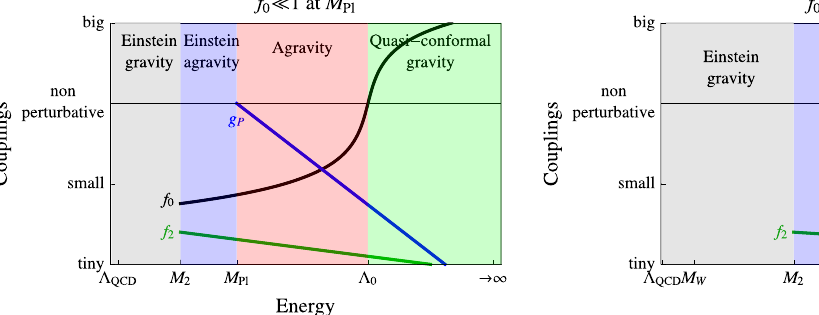
Fig. 1 RGE running of the main dimensionless couplings f 0 , f 2 , g P inthetwopossiblescenariosthatdonotleadtounnaturallylargecorrec- tions to the Higgs mass: f 0 , f 2 (cid:4) 1 at the Planck scale (left), f 2 (cid:4) 1